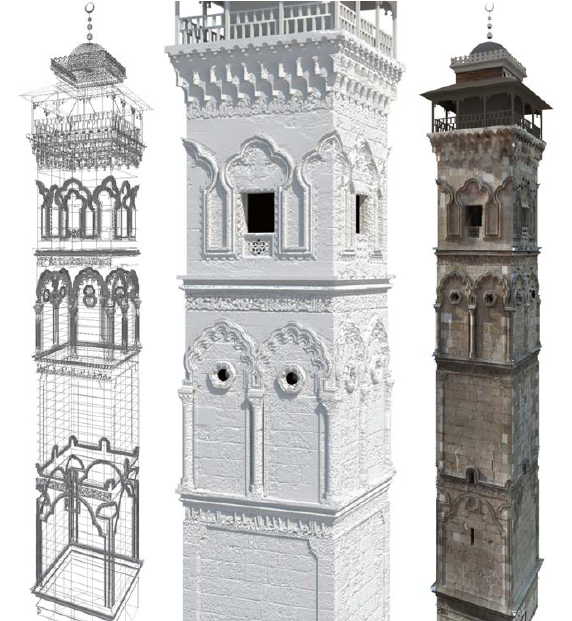
Figure 4. The 3d model of the destroyed minaret of the Umayyad mosque in Aleppo. Performed using panoramic image-based modelling method.